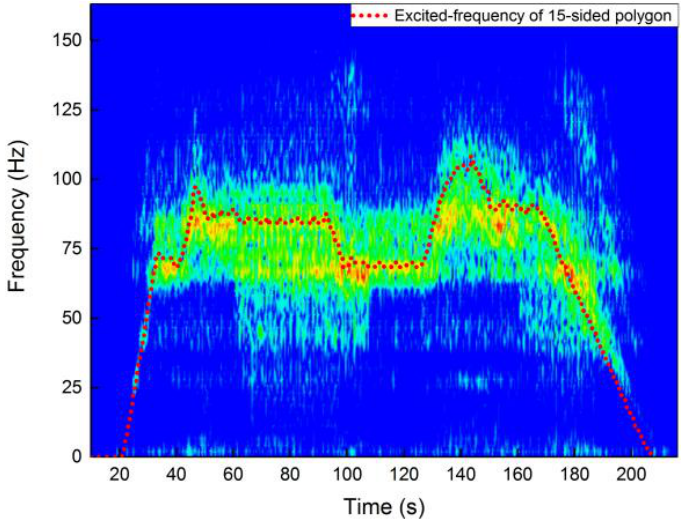
Figure 14. The frequency comparison between dynamic stress at point D11 and excitation from the wheel polygon phenomenon.